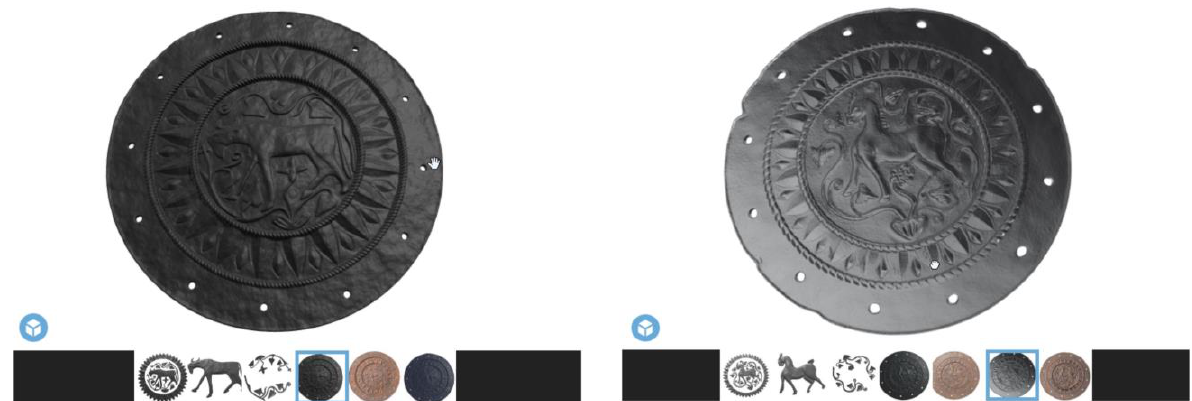
Figure 22. The 3D reconstruction of the two looted Dacian embossed shields.